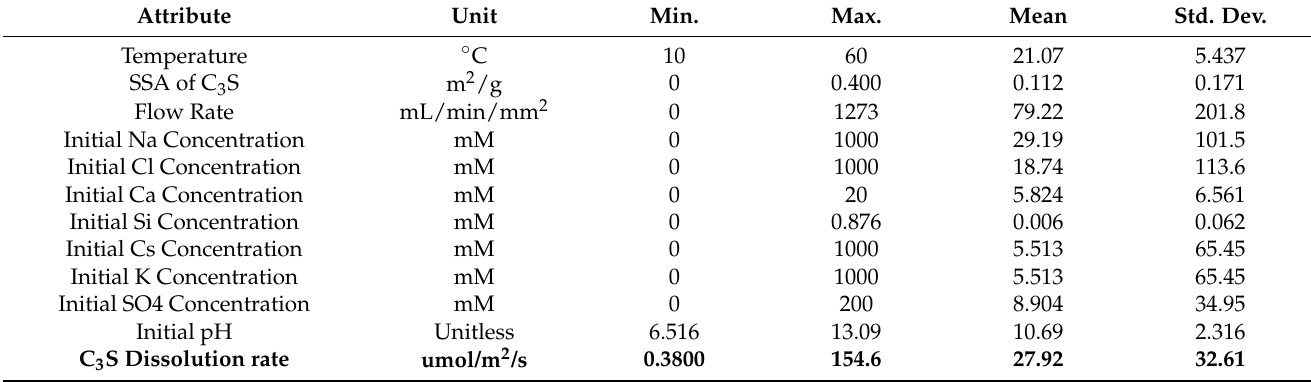
Table 2. Four statistical parameters pertaining to the 12 parameters (11 inputs and 1 output in bold) of the C 3 S dissolution database. The database consists of 292 unique data